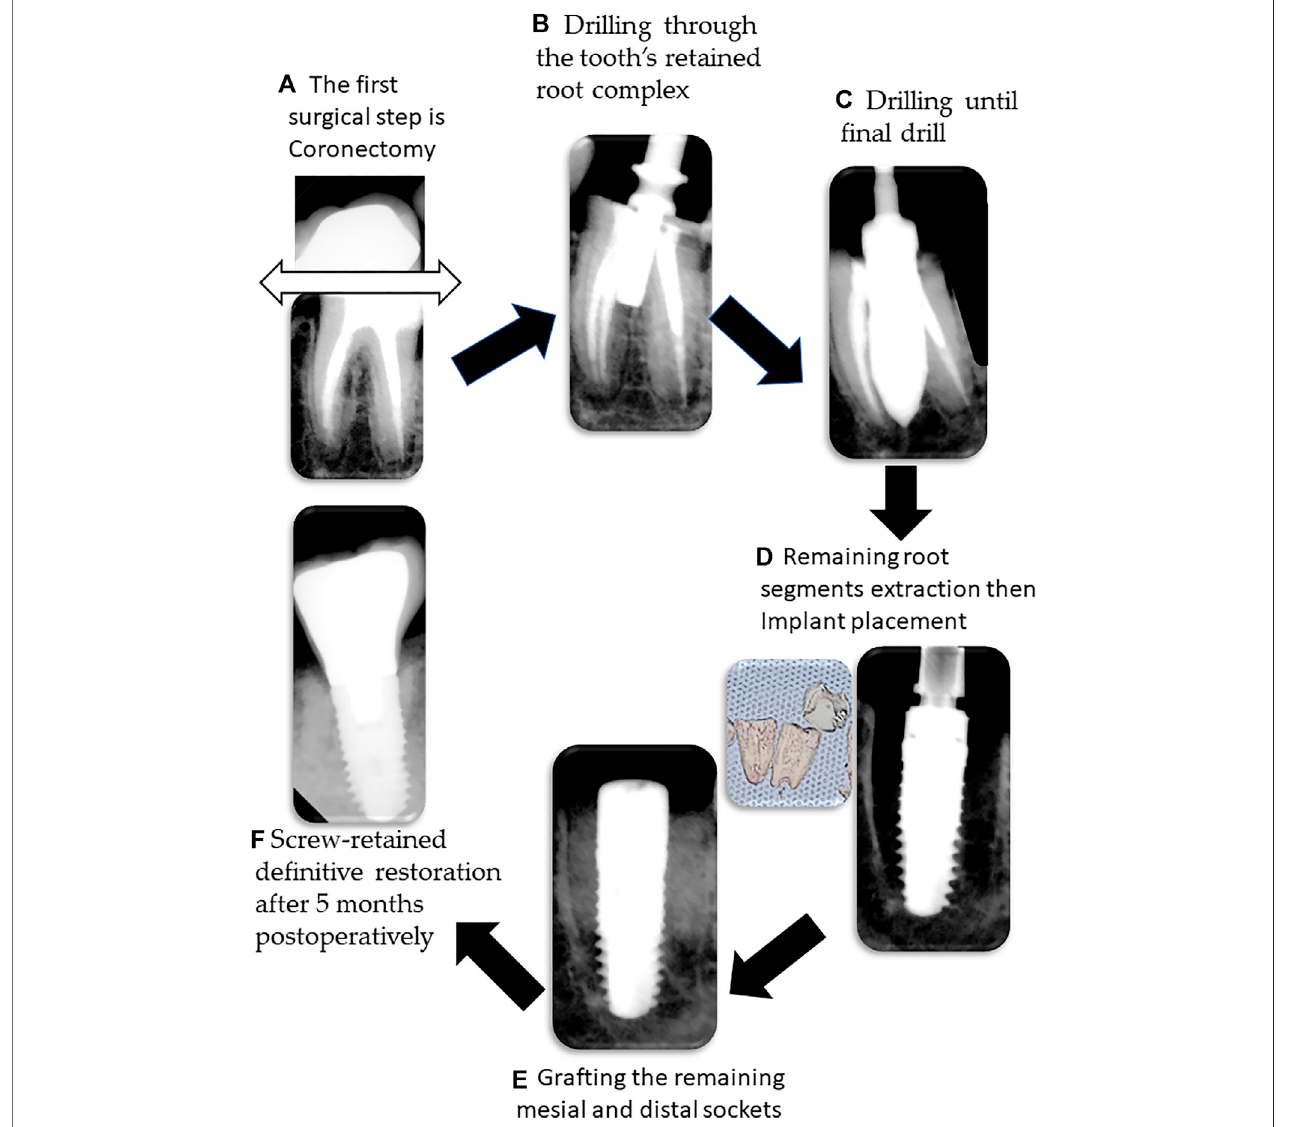
FIGURE1| Illustrationofthesurgicalproceduresteps. (A) Initialsurgicaliscoronectomyusingahighspeedtapereddiamondburcoronectomy; (B) afterforminga dimpleintheroofofthefurcation,drillingthroughthetooth ’ sretainedrootcomplexisperformed; (C) fi naldrillingisperformed; (D) rootseparationiscarriedoutandthen the remaining root segments are extracted followed by implant placement; (E) bone graft is placed in the mesial and distal sockets; (F) after 5 months postoperatively, screw-retained de fi nitive restoration is delivered.